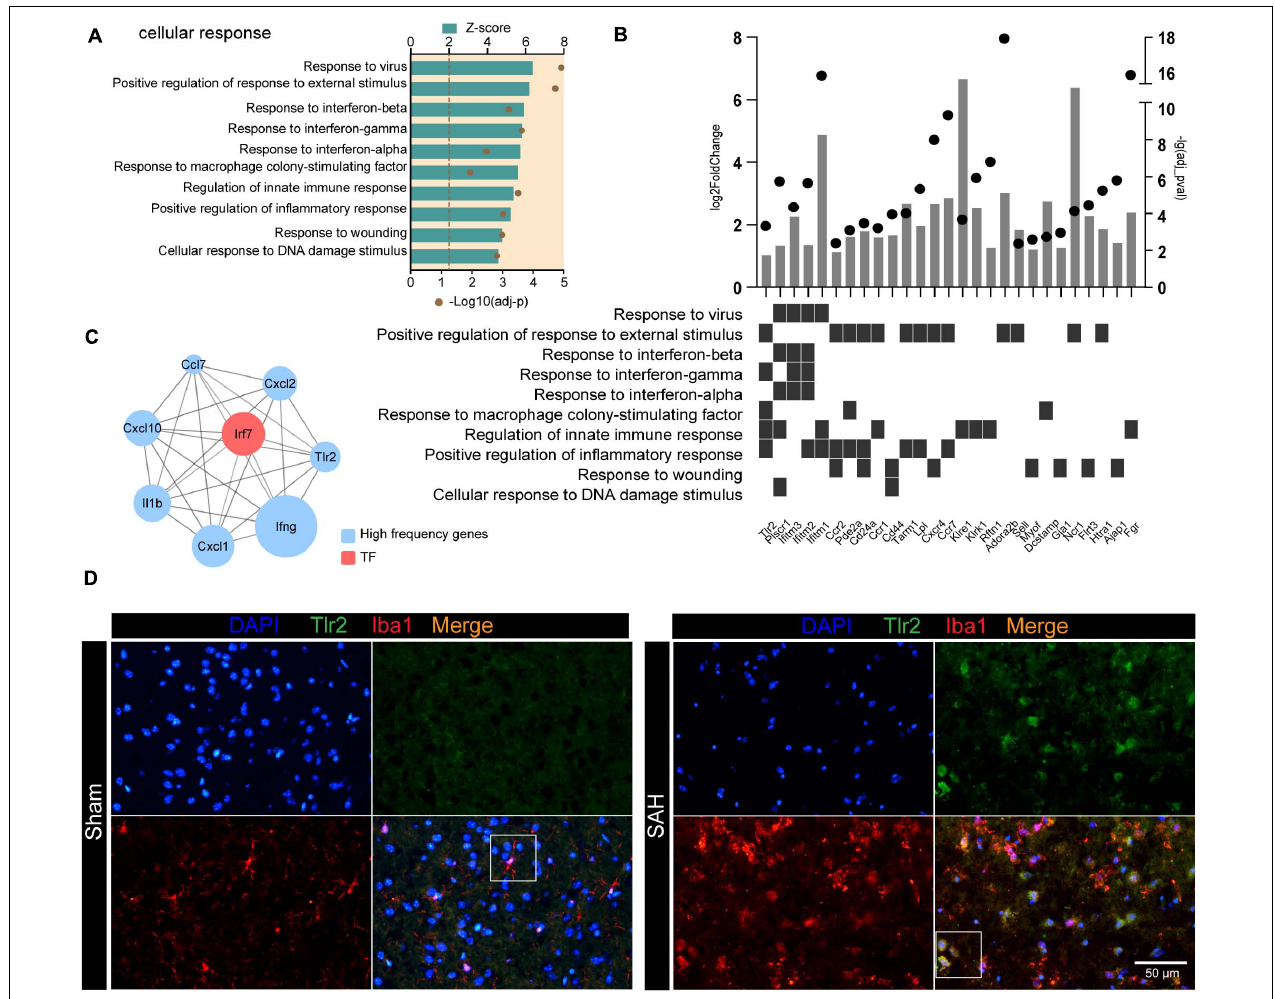
FIGURE 5 | TLR2/IRF7 signaling axis potentially mediates neuroinflammation after SAH. (A) GO enrichment analysis was performed by Metascape on all DEGs in sham and SAH microglia. Shown are the z -scores of biological functions on cell response-related pathways. (B) Expression profiles of DEGs (fold change > 2, adj_pval < 0.01) in SAH microglia related to cell response-related pathways. (C) Top 10 hub genes identified by CytoHubba. (D) Immunofluorescence staining results of Tlr2 and Iba1 in sham and SAH mice, n = 3 per mice group. DEG, differentially expressed